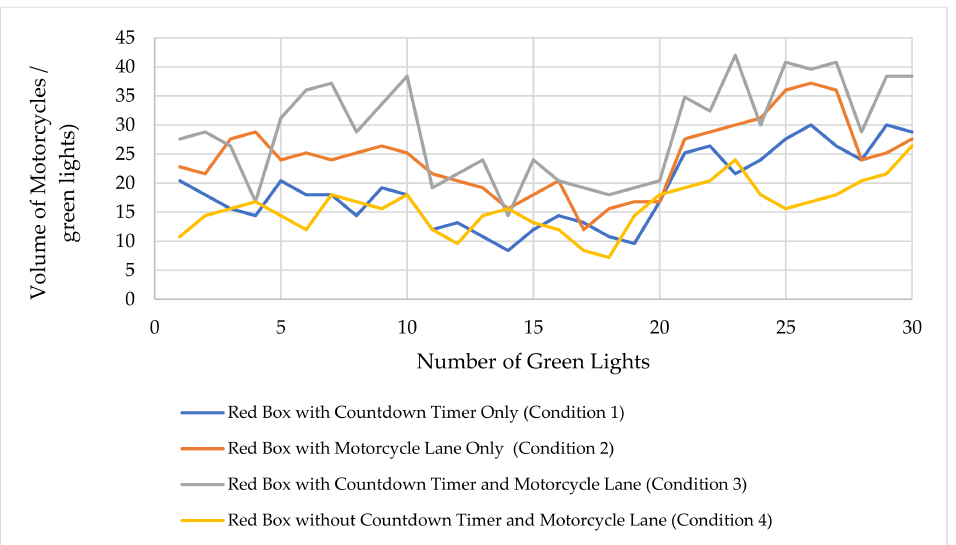
Figure 8. Volume of motorcycles occupying the red box for